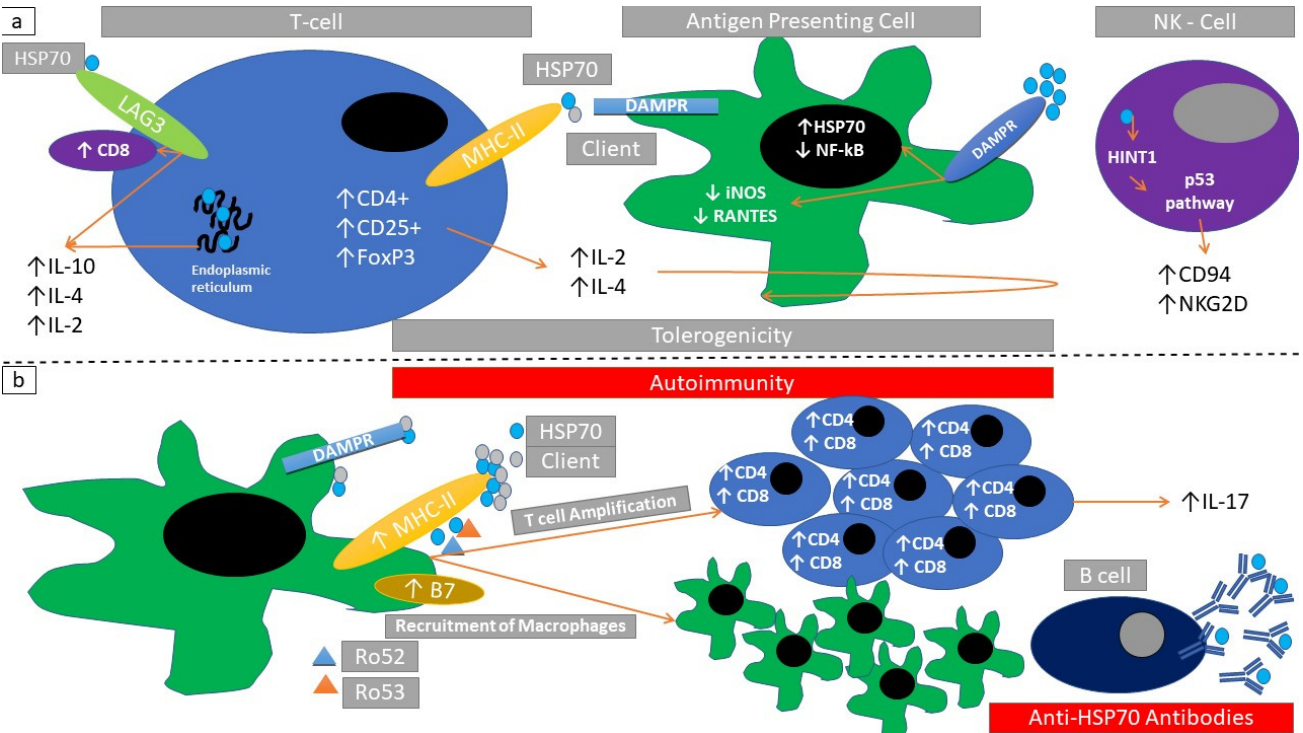
Figure 4. Immunomodulatory actions of HSP70 ( a ) HSP70/client protein-complexes induced signaling through HLA-DR binding in T-regulatory cells. Endoplasmic reticulum HSP70, binding of HSP70 with LAG3 receptor increases IL-2, IL-4, and IL-10. This induces inactivation of antigen-presenting cells (inducible nitric oxide synthase reduction-iNOS, regulated on activation of normal-T-cell-expressed and secreted reduction-RANTES). These changes can also be induced through direct binding of HSP70 with damage-associated molecular pattern receptors (DAMPR). Further exposure to HSP70 can induce HINT1 (histidine triad nucleotide-binding protein) signal transduction leading to increased expression of CD94 and NKG2D in NK-cells. Collectively these changes promote tolerogenicity. ( b ) HSP70/Ro52 and HSP70/Ro53 complexes induce macrophage infiltration and cytotoxic T-cell infiltration. A parallel autoantibody production against HSP70 may coexist. Collectively these changes promote autoimmunity.